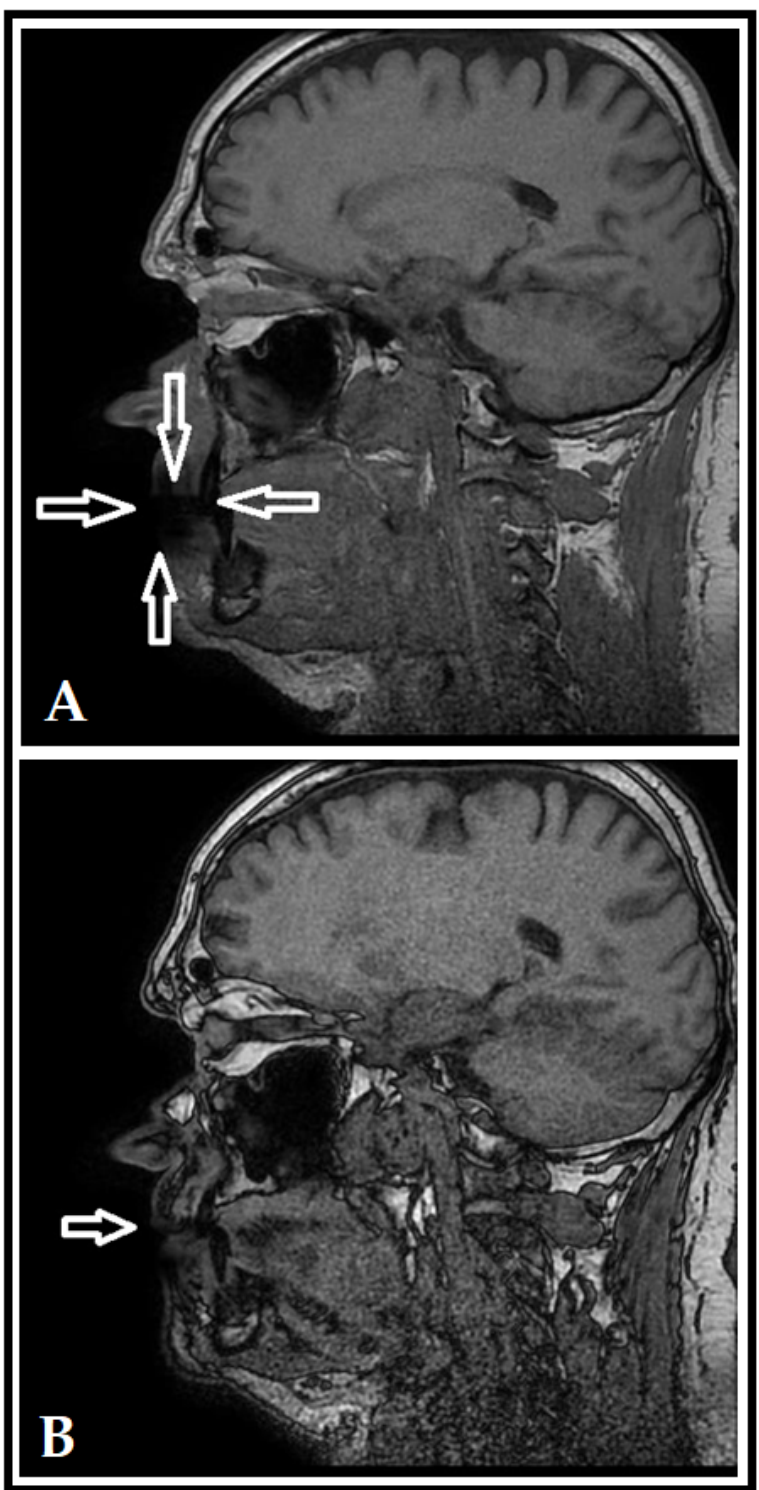
Figure 2. Unadjusted ( A ) and adjusted ( B ) MRI scans for Patient 2 (T1 sag). The shadow in the area of the lips (denoted by white arrows) indicates the imaging artefact caused by Cu accumulation in the lips, which is less pronounced after using adjusted directions and measurements.